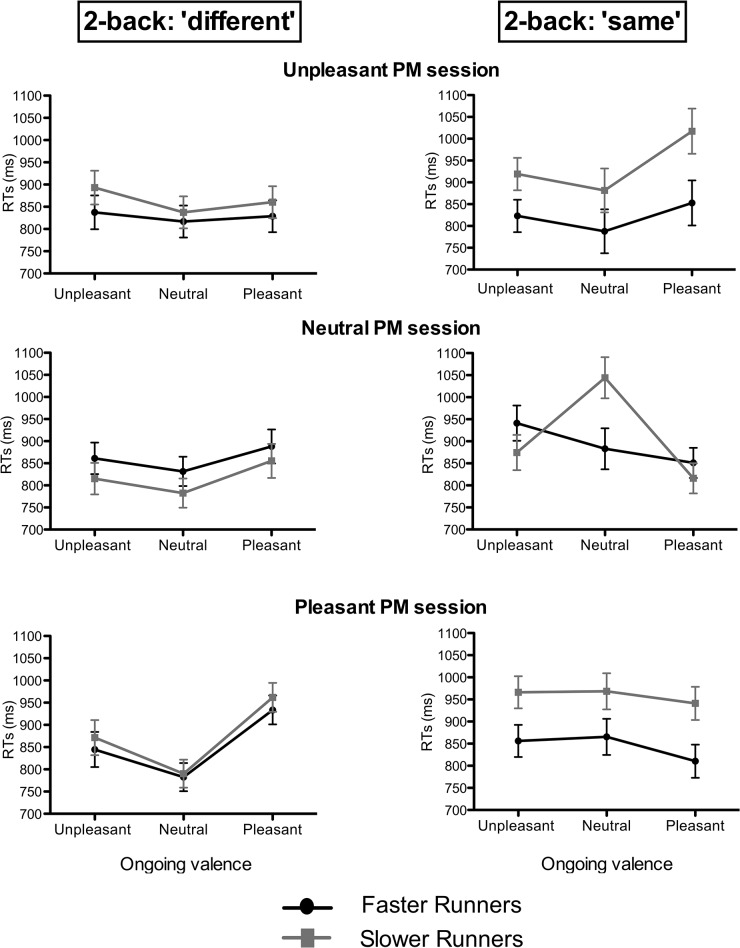
Mean reaction times (RTs) in the ongoing 2-back task, separately for each type of PM cue valence and ongoing stimulus valence.Runners group differences were observed in the ‘same’ trials, especially when participants had to monitor for unpleasant and pleasant PM cues and when the valence of the PM cue matched the valence of the ongoing stimuli.